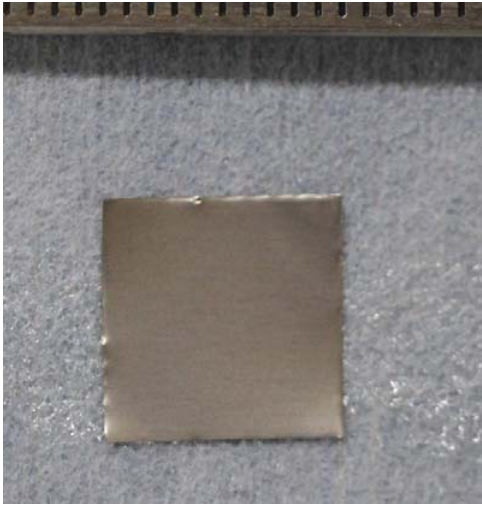
Figure 1. Titanium membrane.